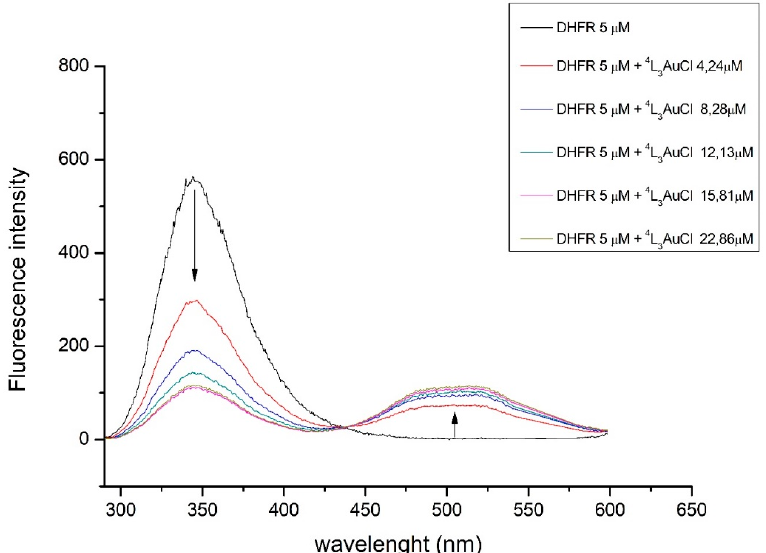
Figure 3. Emission spectra recorded for DHFR upon adding increasing concentration of 4 L 3 AuCl ( λ exc = 280 nm). In the inset legend, the color corresponds to the curve and the respective concentrations. The spectra show the quenching of the DHFR’s tryptophan emission upon the addition of the gold compound and the concomitant increase of the emission’s intensity, attributed to the gold